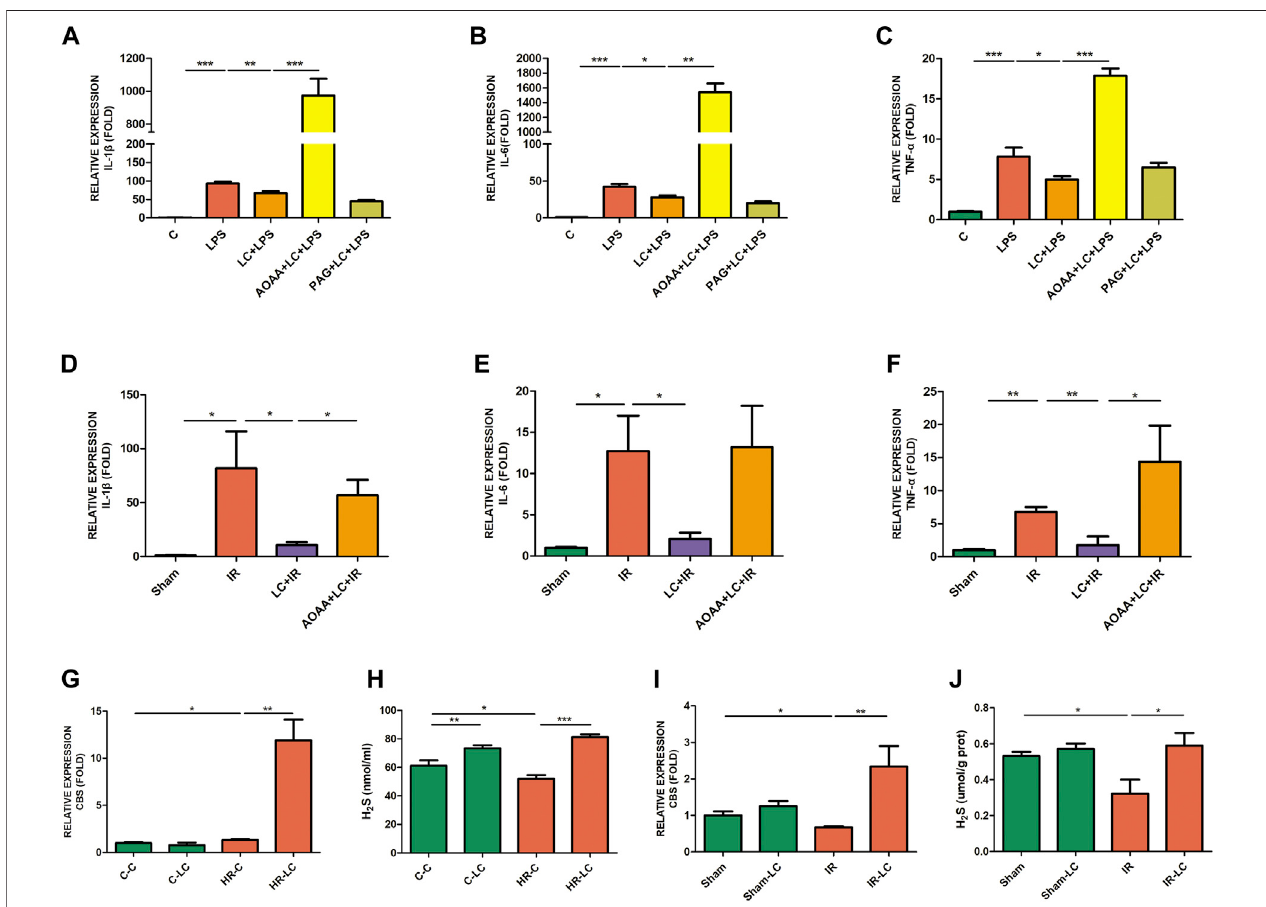
FIGURE4| DecreaseinL-Cys onpro-in fl ammatoryfactorswasblocked byAOAA,and L-Cys up-regulated theCBSand H 2 Sproduction. (A – C) ThemRNAlevels of pro-in fl ammatory factors IL-1 β , IL-6, and TNF- α were detected through AOAA or PAG preincubation of RAW264.7 cells by qRT-PCR. N = 4 /group. (D – F) After injectingAOAAinto mice invivo ,themRNAlevelsofpro-in fl ammatoryfactors IL-1 β ,IL-6,and TNF- α weredetected byqRT-PCR. N=5 /group. (G,I) ThemRNA levelsof CBS in PMs or ileac MCs were detected under normal/Sham and HR/IR conditions by qRT-PCR. N = 4 /group. (H,J) The H 2 S concentration was detected under normal/Sham and HR/IR conditions by a detection kit. N = 6 or 4 /group. Values are mean ± SEM , * p < 0.05, ** p < 0.01, and *** p < 0.001 according to ANOVA with the Newman – Keuls test .